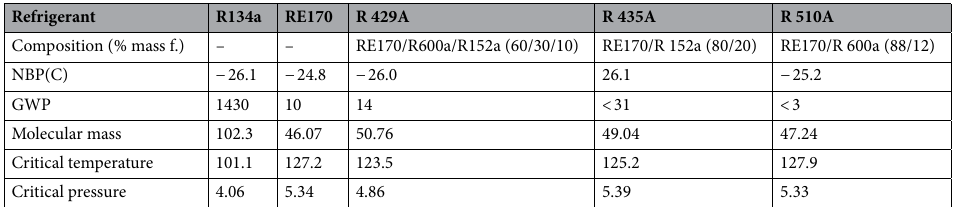
Table 1. Properties of investigated refrigerants.